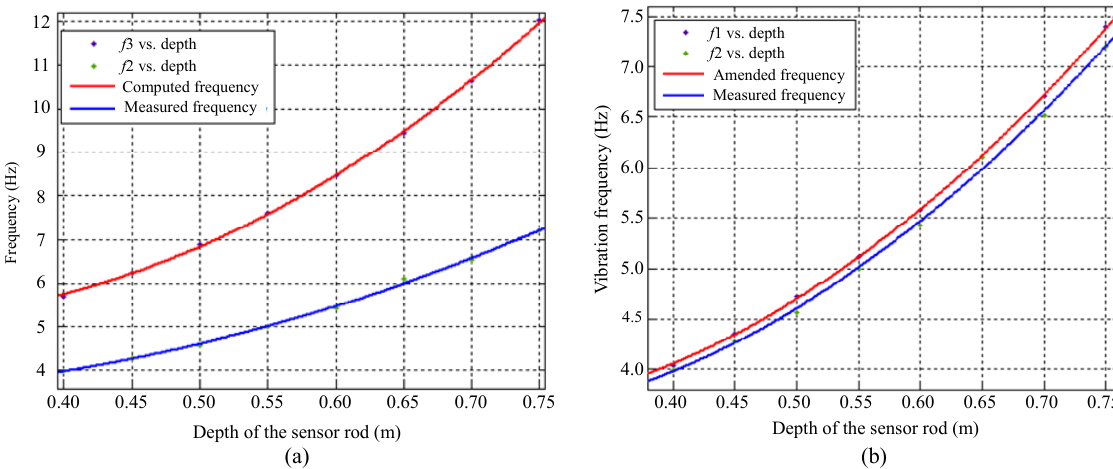
Fig. 9 Comparison of measured frequency with (a) computed frequency and (b) computed frequency (amended).